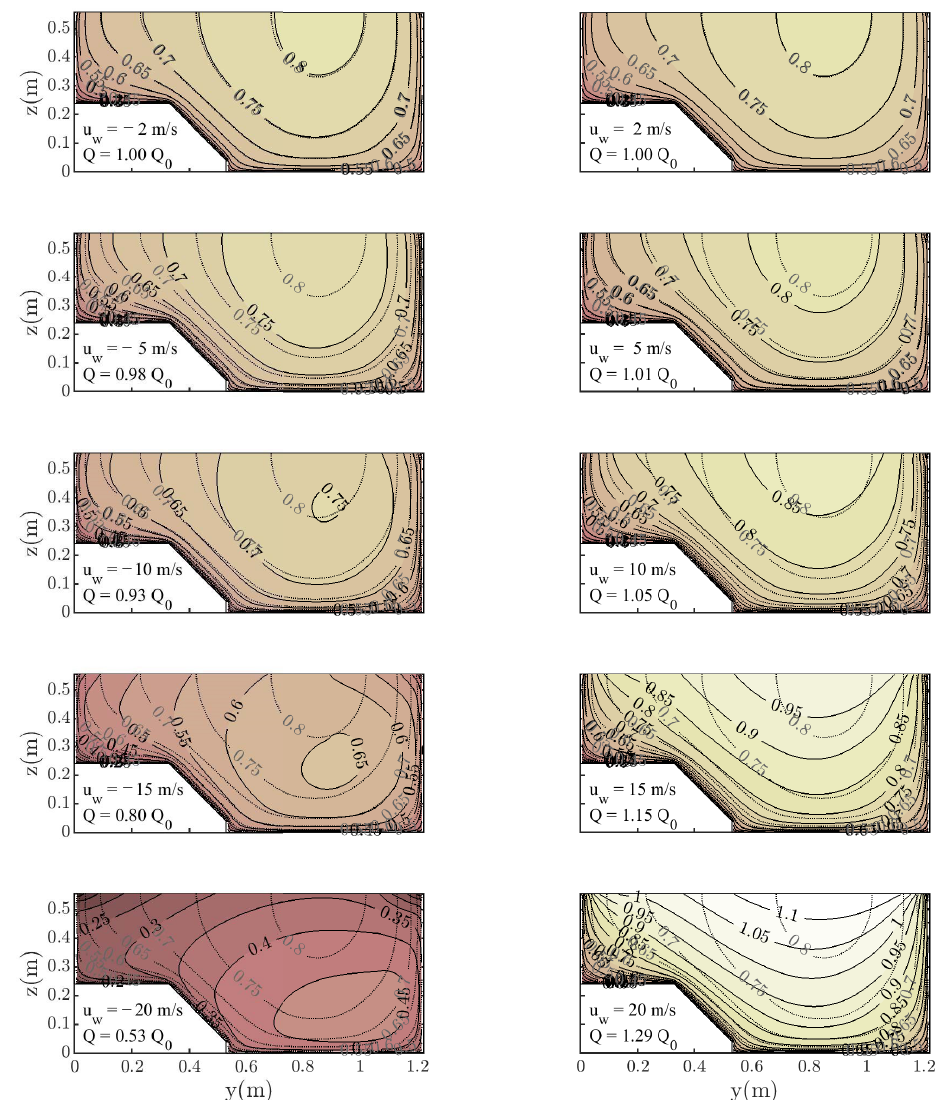
Figure 17. Effect of wind speed on the velocity field for the experiment of Kean et al. [17]. Grey lines are the results for the case u w = 0 m/s where the calculated flow rate is Q 0 = 0.4062 m 2 /s.